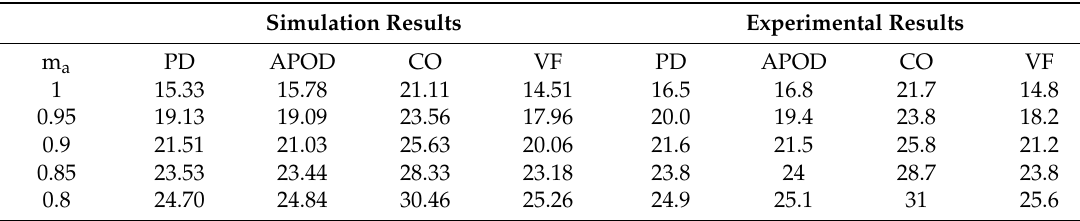
Figure 14. FFT plot for the output voltage of the VFPWM strategy. Table 2. %THD for different modulation indices.